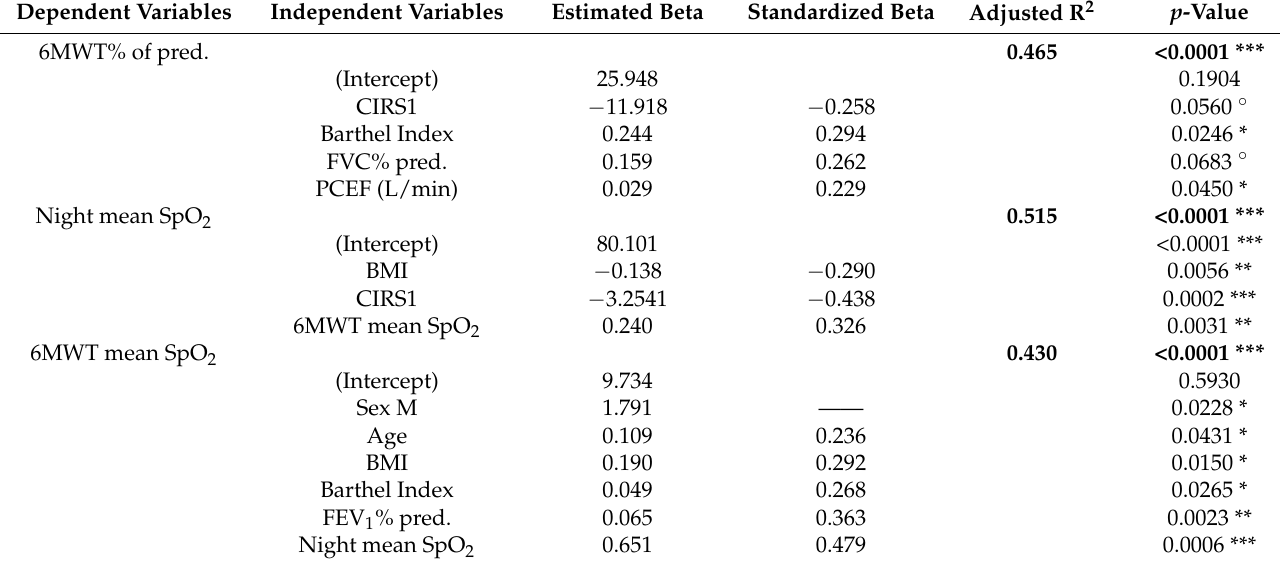
Table 2. Multiple regression analysis on outcomes as dependent variables: exercise tolerance (expressed as 6MWD% of predicted value), Night mean SpO 2 , and 6MWT mean SpO 2 .